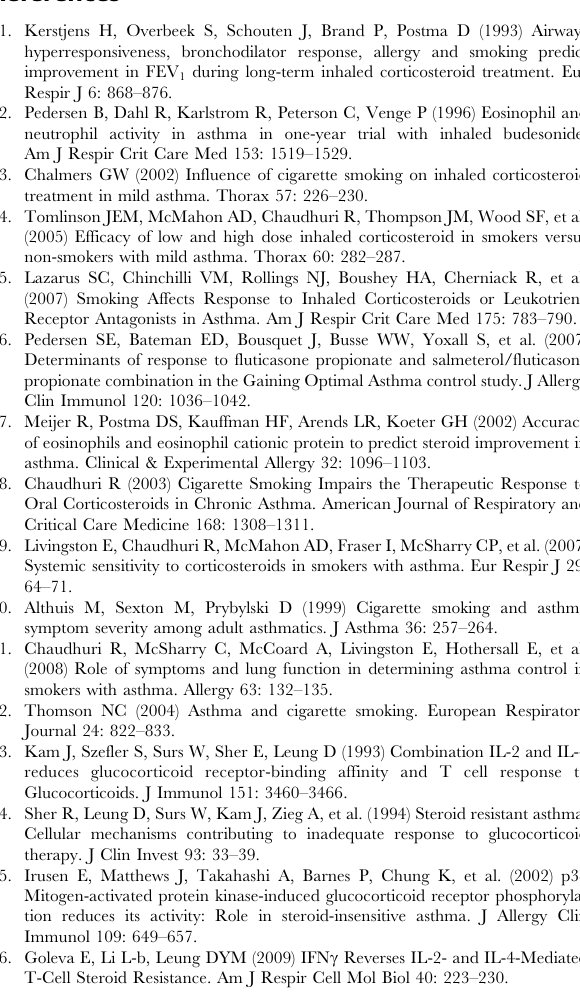
Figure S1 Principal component analysis plot of pre dexamethasone sputum supernatant cytokines (IL1 b , 1RA, 2R, 6, 7, 13, 17, IFN a , GMCSF, CCL2, 3, 4 & 5, CXCL8, 9 & 10) including data from ex-smokers with asthma. Principal component 1 represents 57% of variance in data, Principal component 2 16%. Based on examination of the component loadings we interpret principal component 1 as being principally driven by the sputum supernatant cytokines IFN a , IL1 b , 2R, 7, 12, 13, 17 & GMCSF and principal component 2 IL6, 8, CCL2, 4 and CXCL10. Table S1 Number and percentage of sputum superna- tant samples per cytokine (grouped according to smok- ing history) below the manufacturer’s recommended lower limit of detection. Table S2 Comparison of smokers with never smokers with asthma pre and post dexamethasone. Table S3 Number and percentage of serum samples per cytokine (grouped according to smoking history)